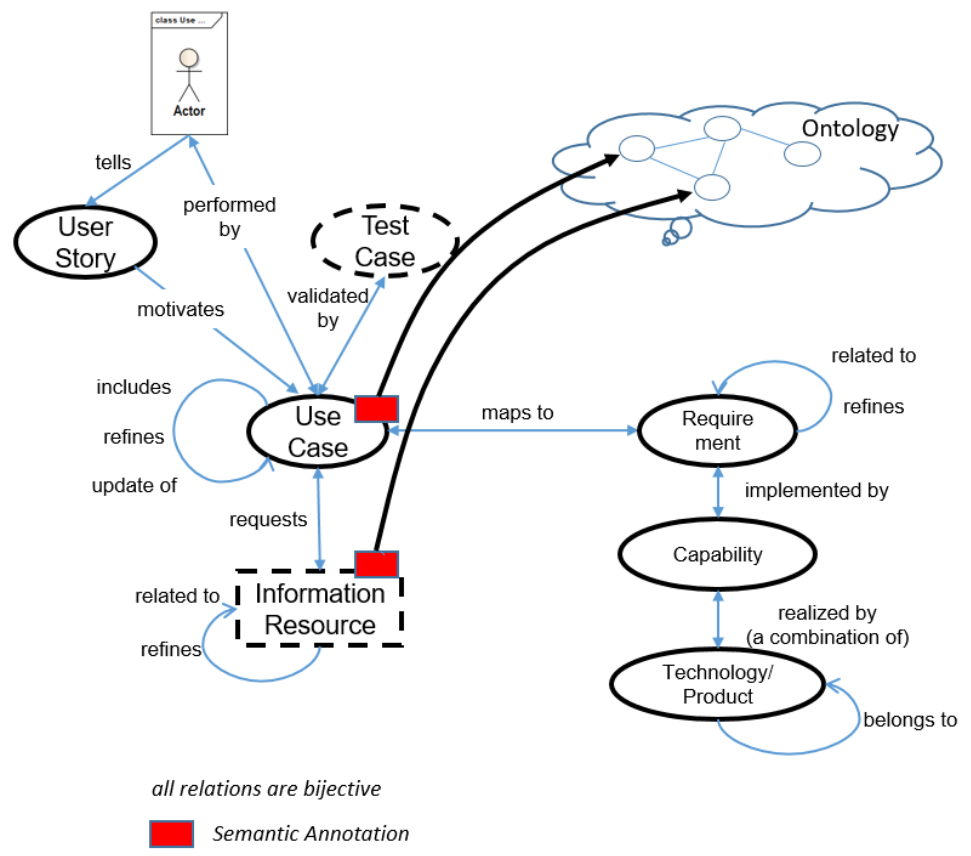
Figure 3. Relations between the major SERVUS meta-model elements.